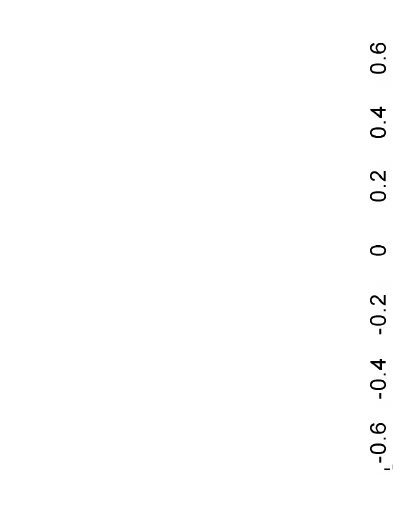
FIGURE 5 | Ordination diagrams of canonical correspondence analysis showing the association of gobiid larvae assemblage with the environmental variables on the two canonical